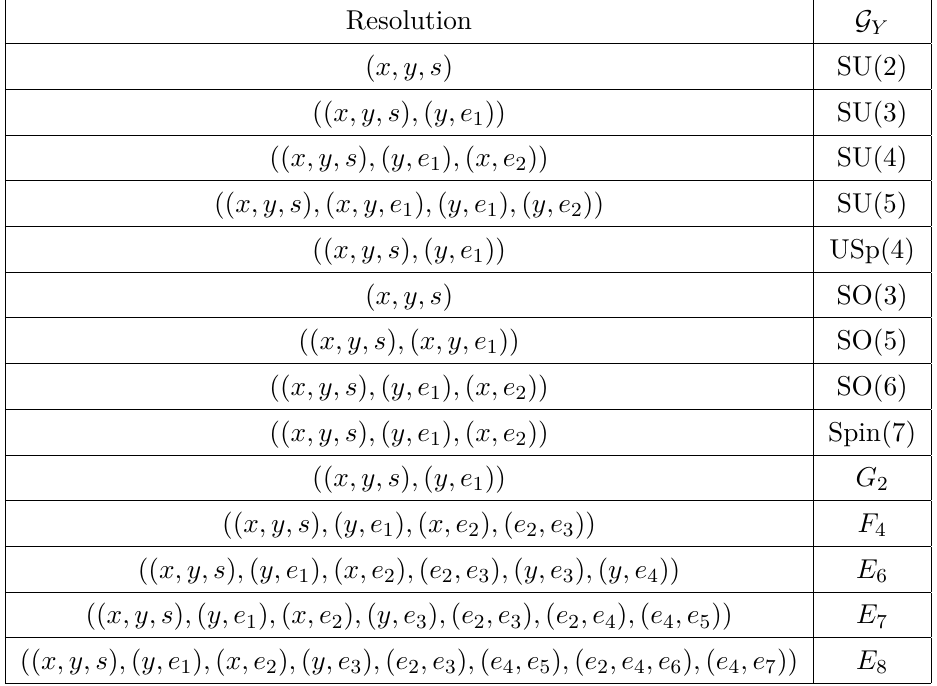
Table 2 . Resolution procedure for each Weierstrass